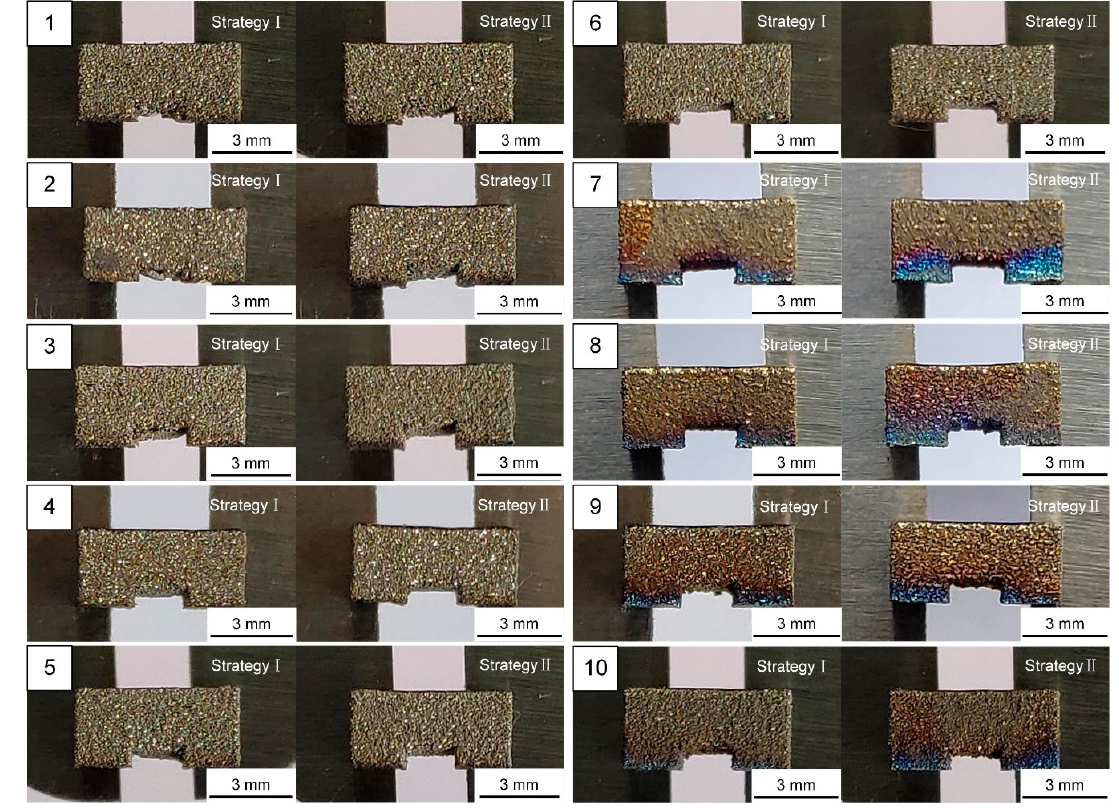
Figure 4. Macroscopic morphology of all overhanging structure samples.